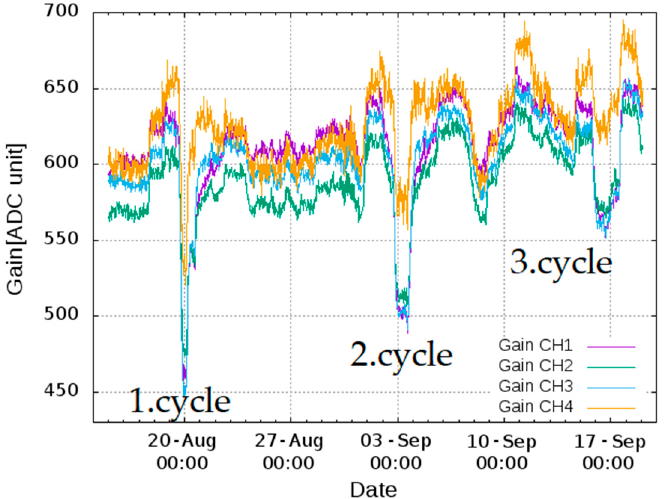
Figure 6. The mean gain values (in arbitrary units, 30 min average) of the four chambers during 36 days of measurement period. Outside the heat cycles, the gains are technically constant.